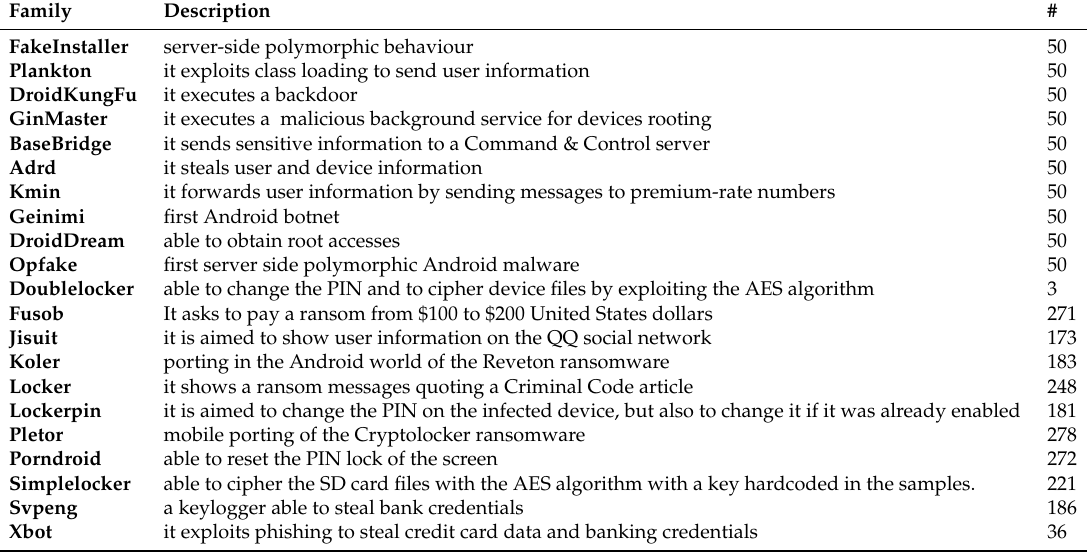
Table 2. Malicious families’ description with the relative number of